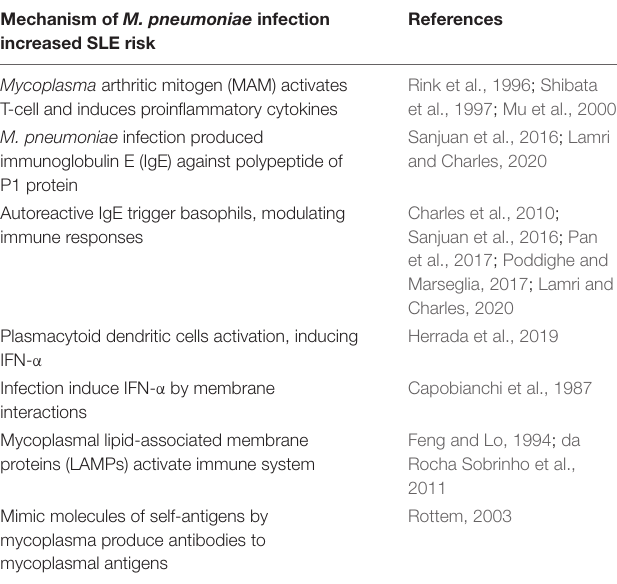
TABLE 4 | The mechanism of M. pneumoniae infection increased SLE risk. Mechanism of M. pneumoniae infection increased SLE